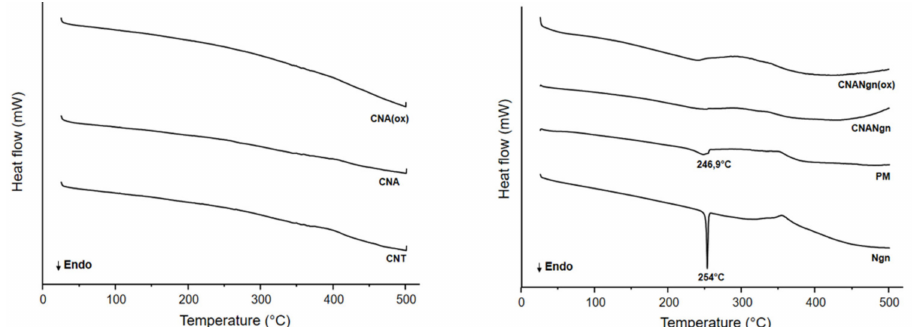
Figure 5. Di ff erential scanning calorimetry (DSC) of CNT (carbon nanotube), CNA (CNT after acid treatment), CNA(ox) (CNA submitted to oxidative environment), CNANgn (CNA treated with naringenin), CNANgn(ox) (CNA treated with naringenin in oxidative environment), PM (physical mixture of CNA and naringenin) and Ngn (naringenin).